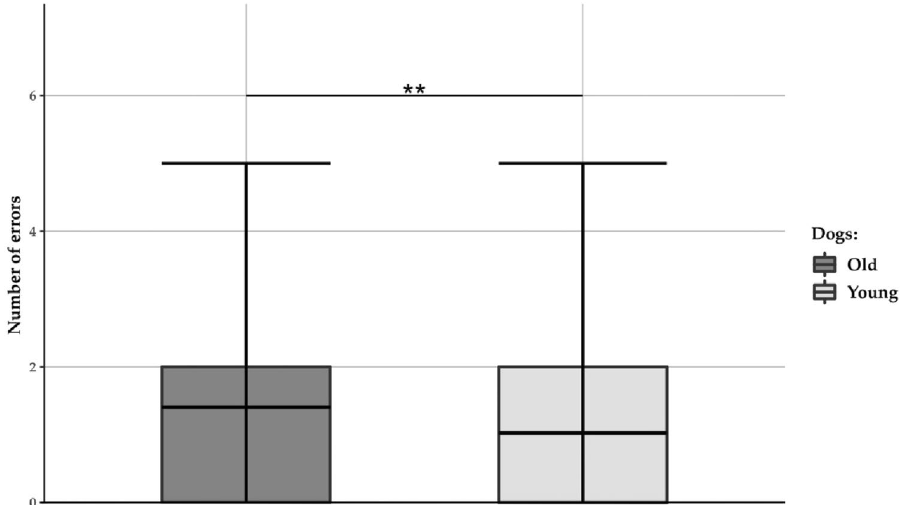
Figure 2. Number of errors in the memory test. On average, the old dogs made more errors in the memory test compared to the young dogs. A breakdown of the number of errors made in the memory test, divided by age group, is presented in the figure. The middle line in the box plots represents the median number of errors, the extremes of the boxes represent the lower and upper quartiles, and the error bars represent the minimum and the maximum number of errors. The asterisks indicate a statistically significant difference between the groups ( ** = p < 0.01).